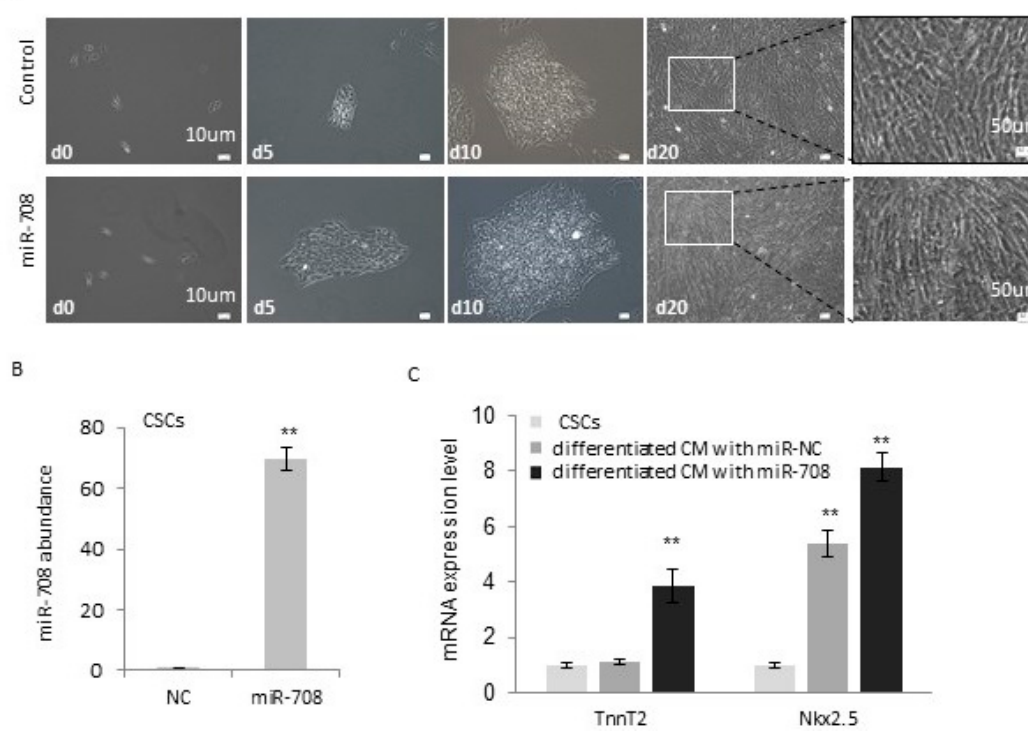
Figure 3. miR-708 promoted differentiation of cardiac stem/progenitor cells to cardiomyocytes. ( A ) Cardiac stem/progenitor cells were transfected with miR-708 mimics or control miRNA mimics followed by a three-week induction of differentiation; ( B ) Confirmation of miR-708 overexpression by QRT-PCR after transfection of miR-708 mimics into c-kit(+) cells; ( C ) Gene expression analysis of cardiomyocyte markers TnnT2 and NKX2.5 in c-kit(+) cardiac stem/progenitor cells before and after differentiation (one week) with or without the overexpression of miR-708. Data are mean ± SEM ( n = 3). ** p < 0.01.